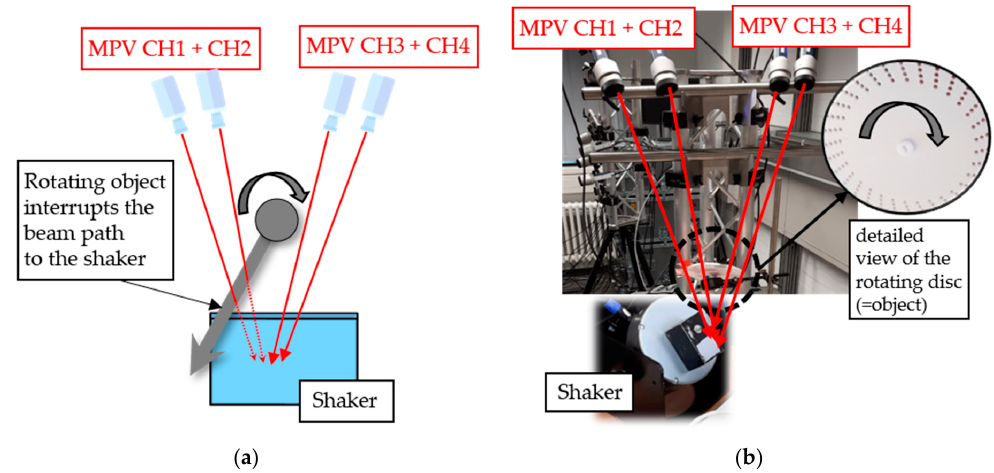
Figure 1. ( a ) Concept of the experiment to obtain velocity signals with signal dropouts; ( b ) Image of the actual test setup; laser beams go to the shaker in a straight line through the holes in the rotating disc.